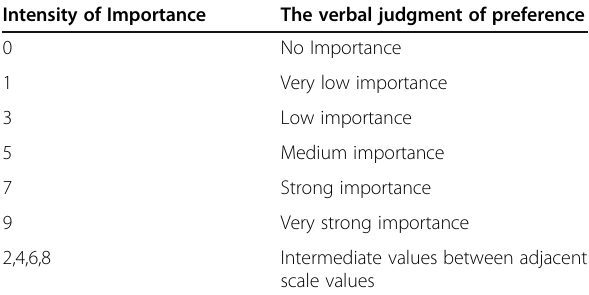
Table 4 Relative importance table of AHP analysis [23] Intensity of Importance